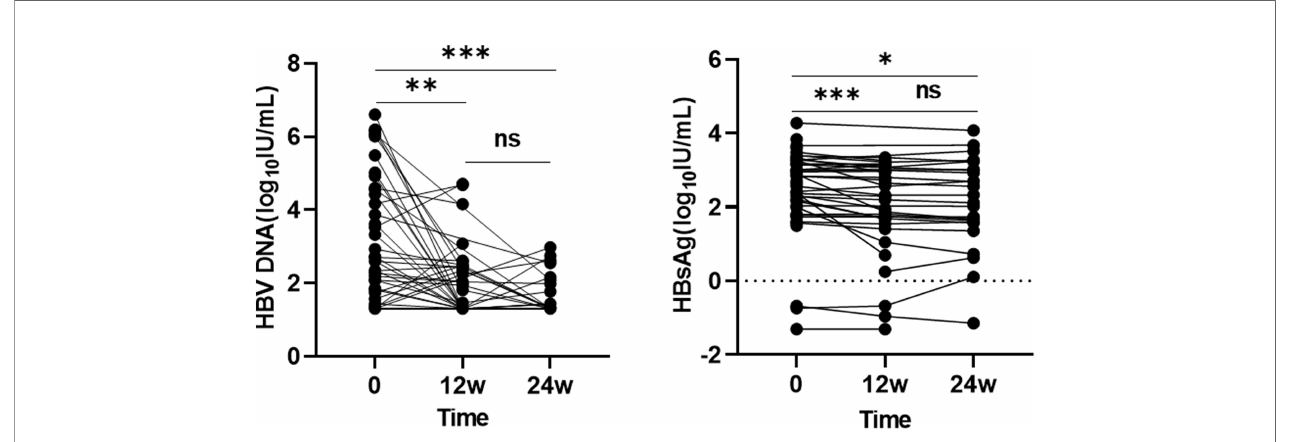
FIGURE 1 | The overall changes in HBV DNA and HBsAg levels at different time point. ns: >0.05; ***: ≤ 0.005; **: ≤ 0.01; *: ≤ 0.05.